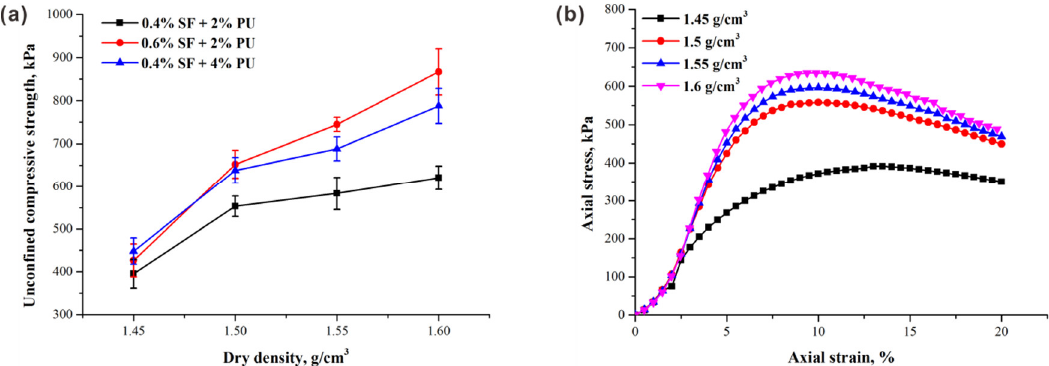
Figure 9. Results of unconfined compression tests in fiber–polymer‐reinforced sand: ( a ) relationship between UCS and sand dry density; ( b ) Typical stress–strain curves of specimens at different dry densities ( = 0.4%, = 2%).